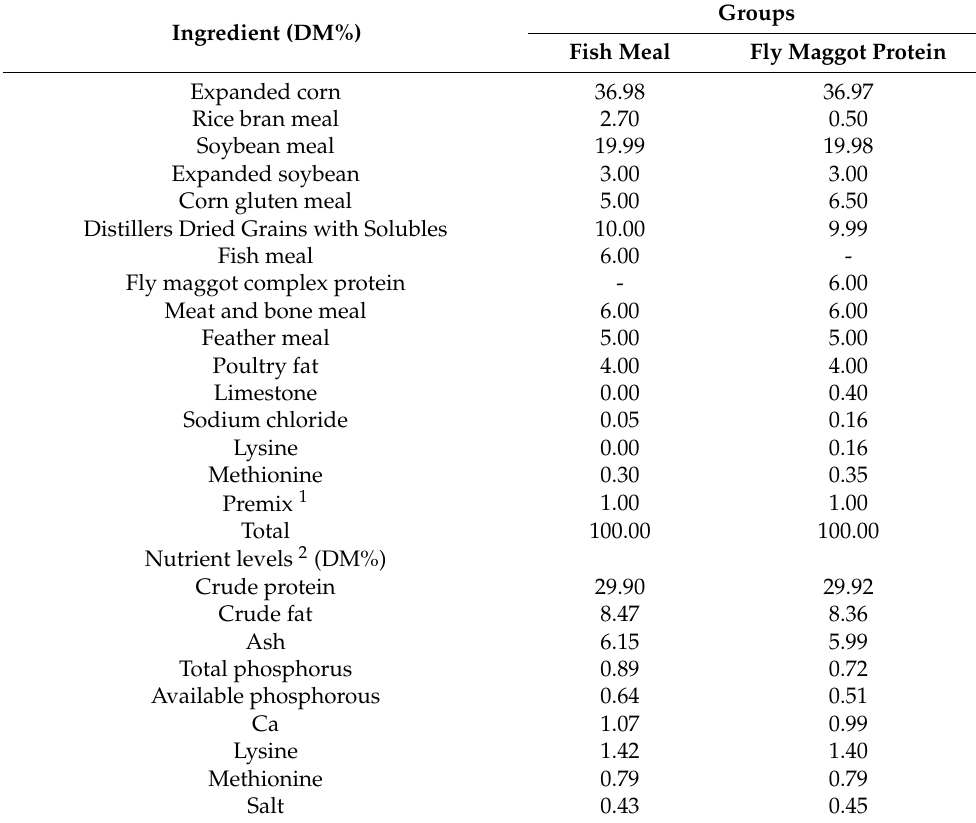
Table 1. Feed formula and nutritional